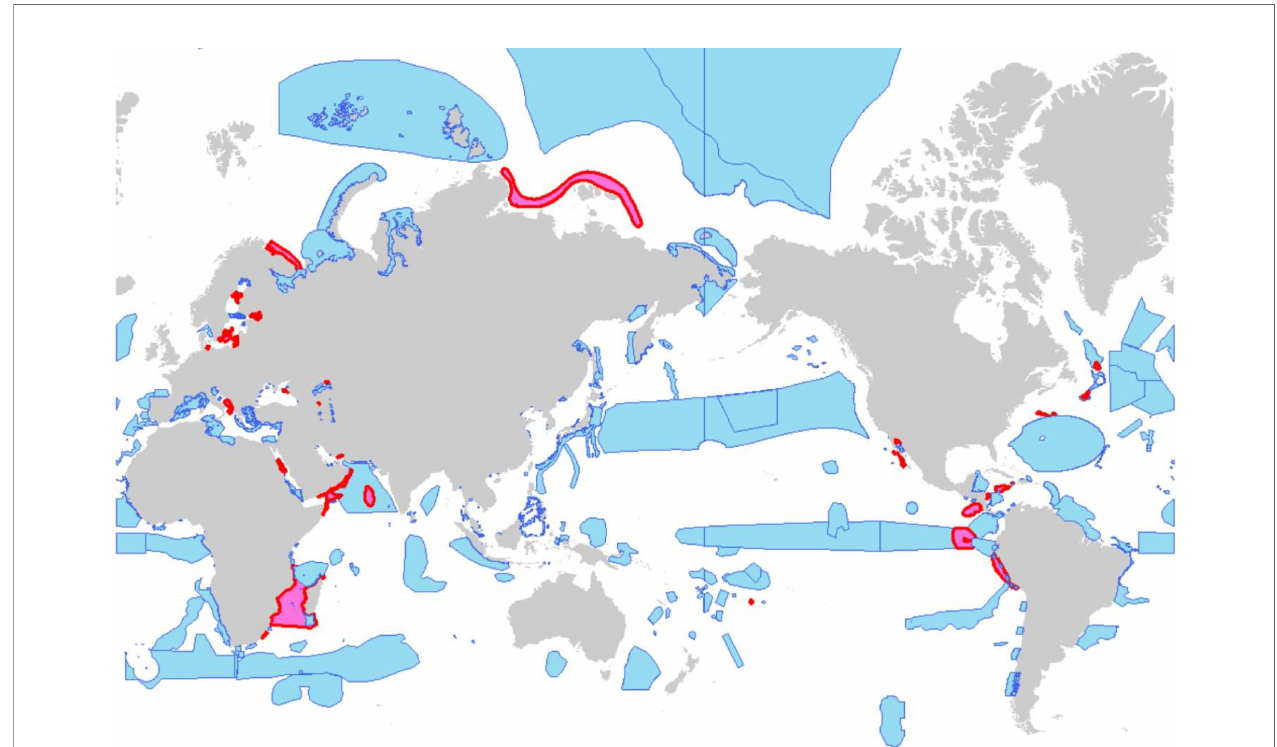
FIGURE 2 | EBSAs in the CBD repository (added information about OSPAR/North East Atlantic) and distribution of use of genetic information. Red and blue, areas that did and did not, respectively, use genetic